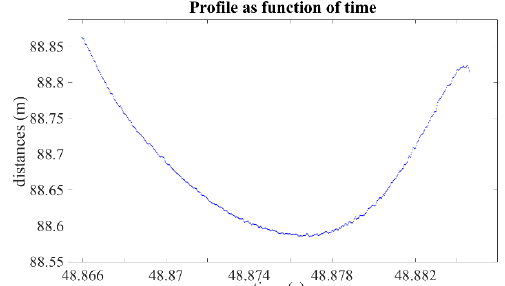
Figure 3. Measured data of a rotor blade run-through at the outer tip with the Z+F Imager 5010 in 1D mode